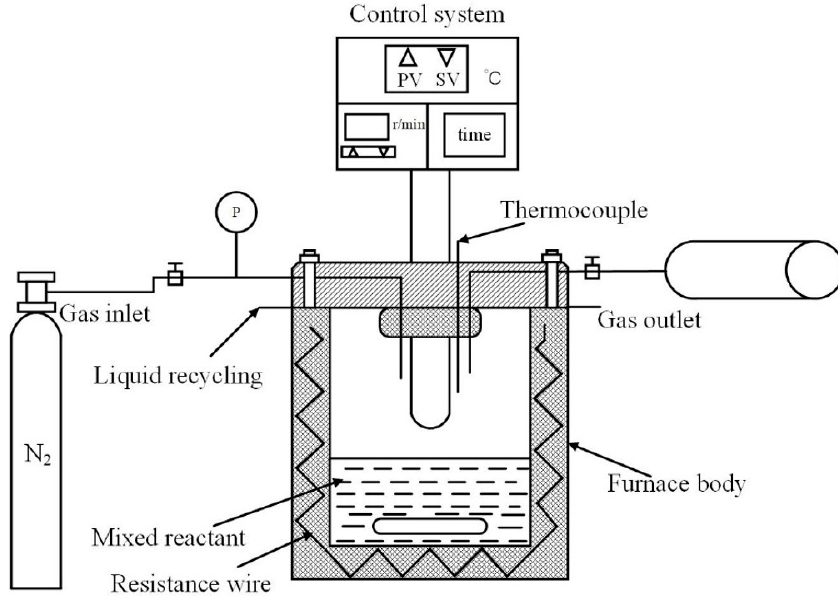
Figure 1. Diagram of HTC equipment. Table 1. Proximate, ultimate analysis and H/C atomic ratio of PS, SHM and SHM-HTC.